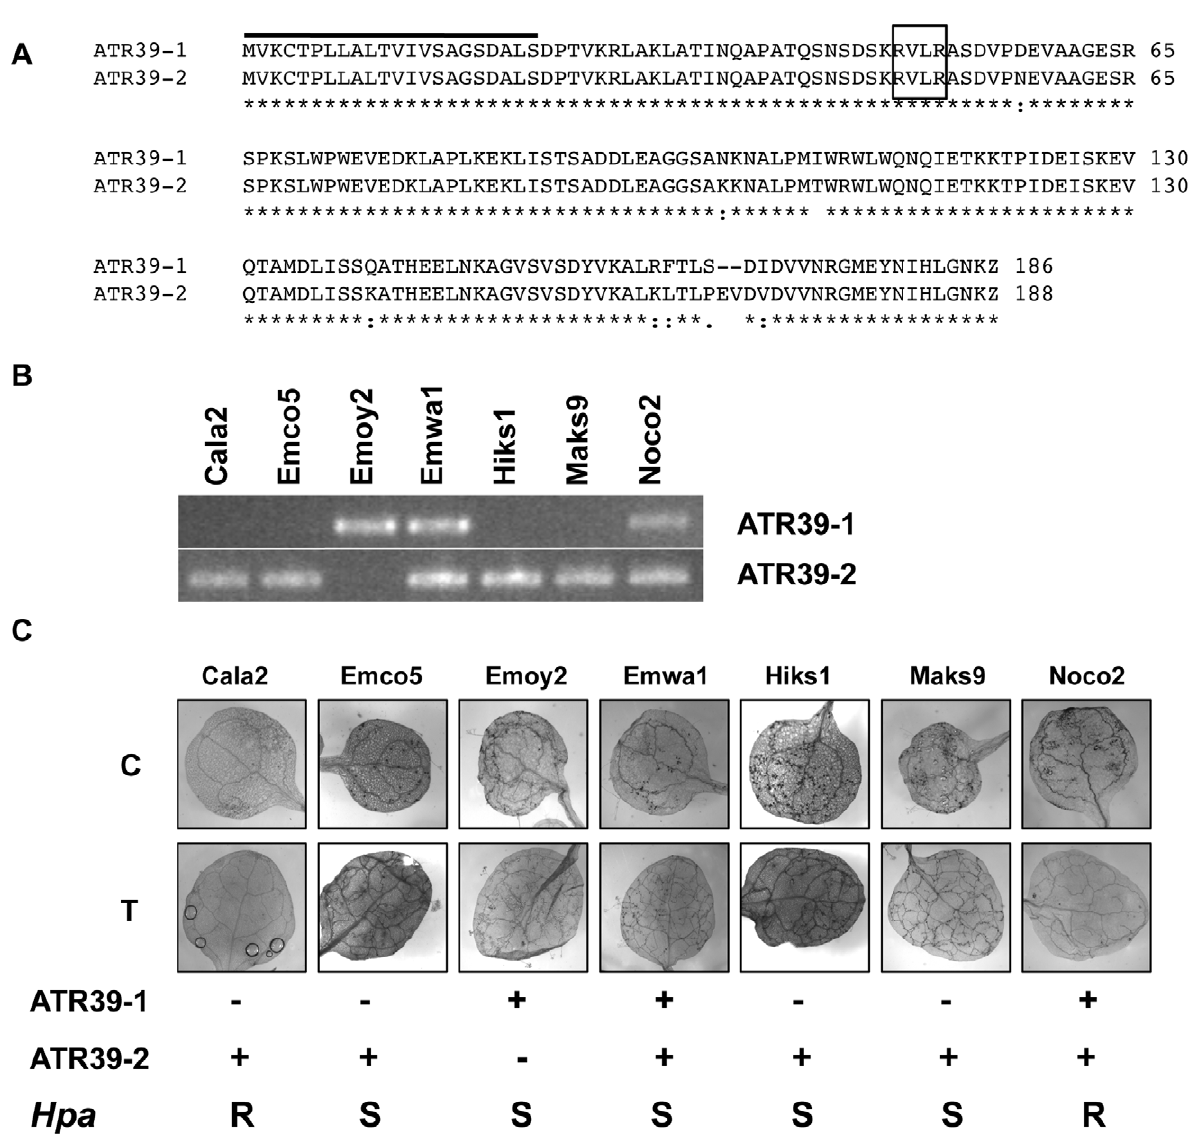
Figure 3. ATR39 alleles are expressed in different Hpa isolates, but expression of ATR39-1 does not correlate with avirulence on Wei- 0. A) Amino acid sequence alignment of ATR39-1 and ATR39-2 using ClustalW. B) RT-PCR with allele-specific primers from plants infected with the indicated Hpa isolates, harvested at 7 dpi. Sequencing of the amplified ATR39 fragments revealed the absence of additional polymorphisms in Hpa strains. C) Trypan blue staining of Wei-0 leaves inoculated with the indicated Hpa strains. Presence or absence of ATR39 alleles is indicated below, as well as qualitative scoring of Hpa growth on Wei-0. C, cotyledons; T, true leaves; S, susceptible; R, resistant.